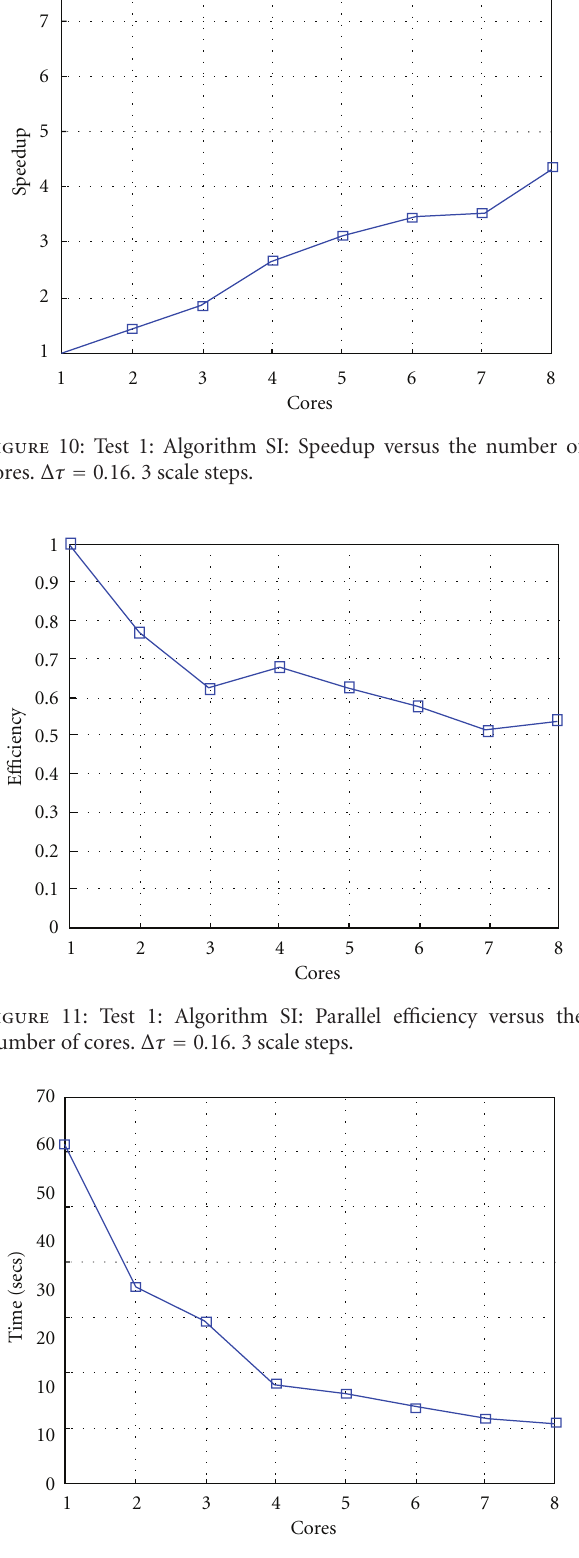
Figure 12: Test 1: Algorithm SI: Total execution time versus the number of cores. Δ τ = 0 . 016.